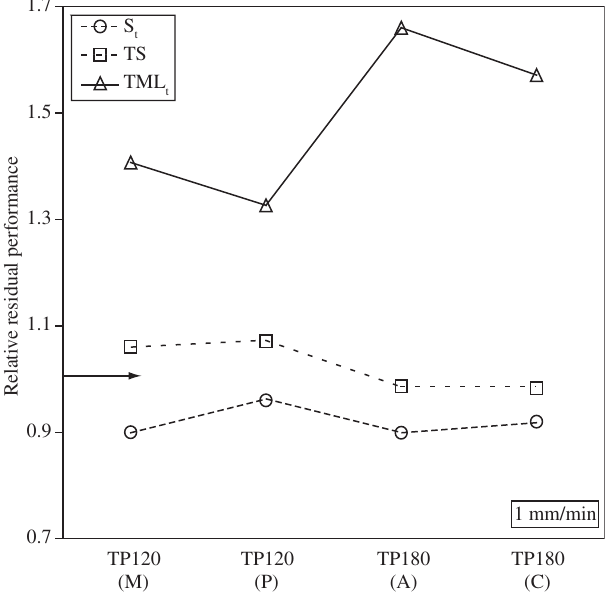
Figure 6. Relative residual tensile properties (based on average results of Table 2) of laminates TP120 and TP180. Point-to-point fits indicate the general trend of data